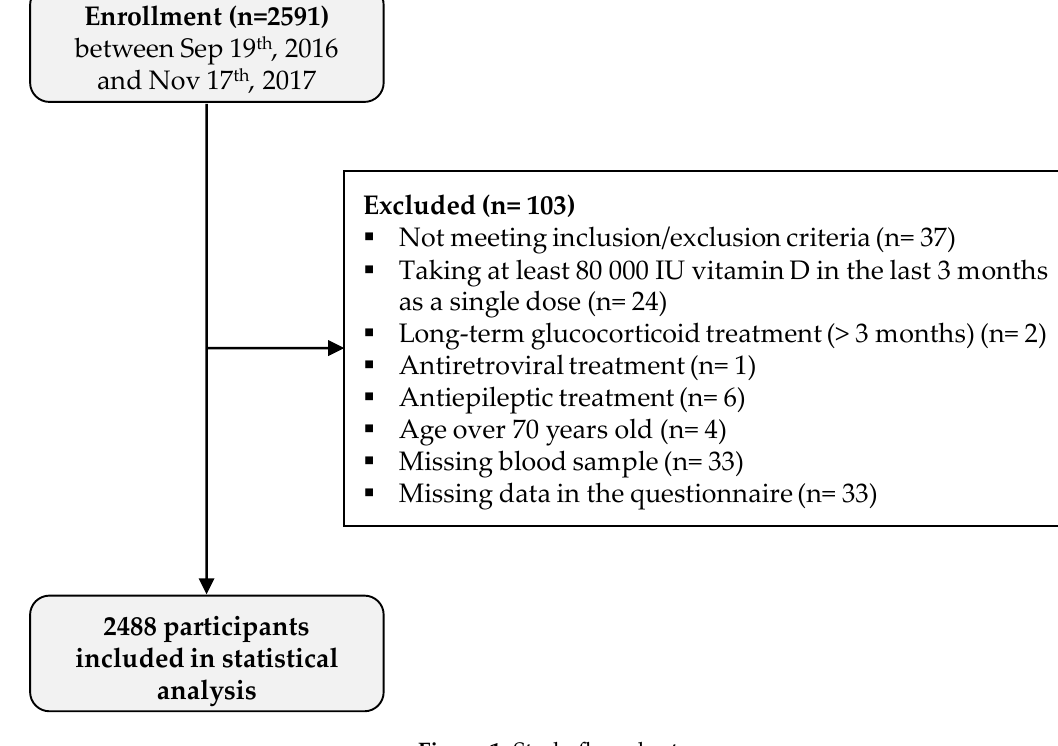
Figure 1. Study flow chart. Table 1. Characteristics of the study population (n = 2488).